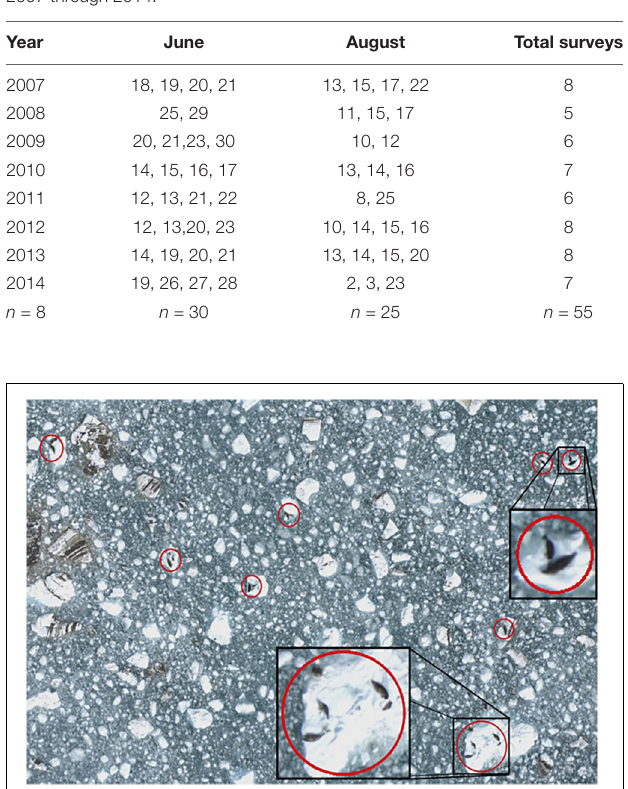
Aerial surveys were conducted under NOAA Fisheries